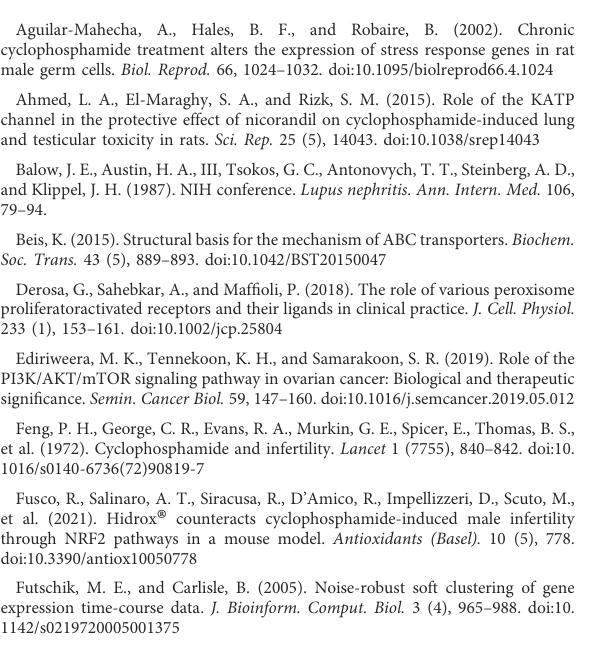
SUPPLEMENTARY TABLE S10 The KEGG enrichment of differentially expressed proteins and metabolites in Ctrl vs. CP. SUPPLEMENTARY TABLE S11 The KEGG enrichment of differentially expressed proteins and metabolites in CP vs. ICA. SUPPLEMENTARY TABLE S12 The primers used in this